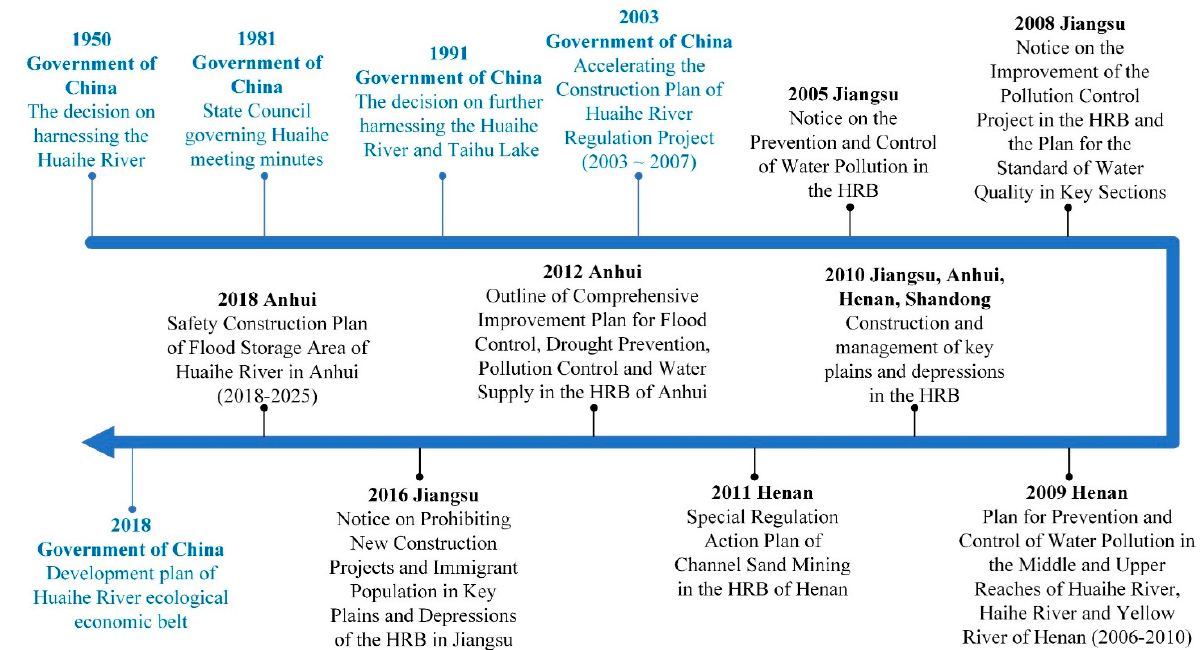
Figure 9. Some important policies issued by the Government of China and governments of the four provinces in the HRB.